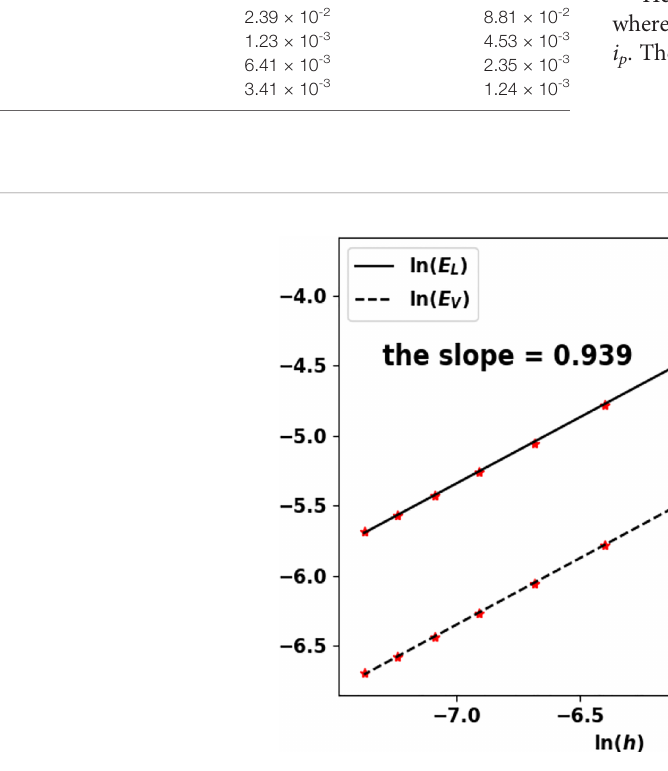
TABLE 8 | Uniform fragmentation, ex. 2, case n = 2: errors for different number of cells. Number of cells